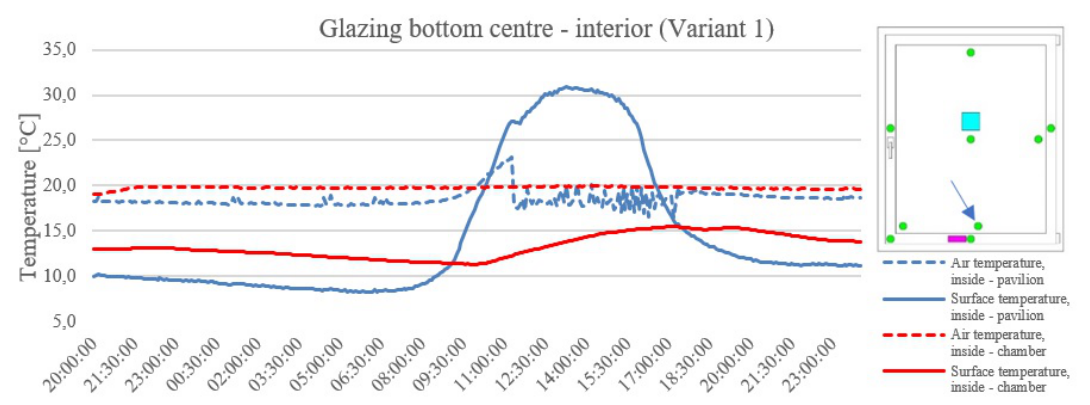
Figure 4. Temperature courses for the bottom of glazing. Variant 1 with constant indoor temperature. Difference of about 3 °C in surface temperatures.